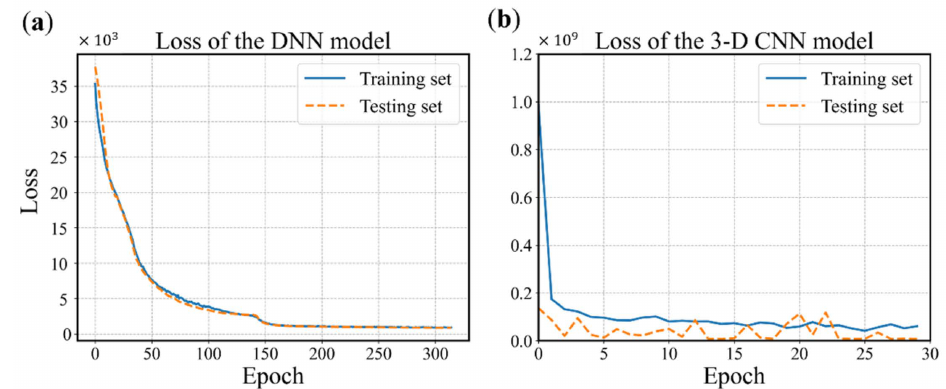
Figure 12. History of loss values. ( a ) The DNN model with 315 epochs. ( b ) The 3D CNN model with 30 epochs (0 to 29).